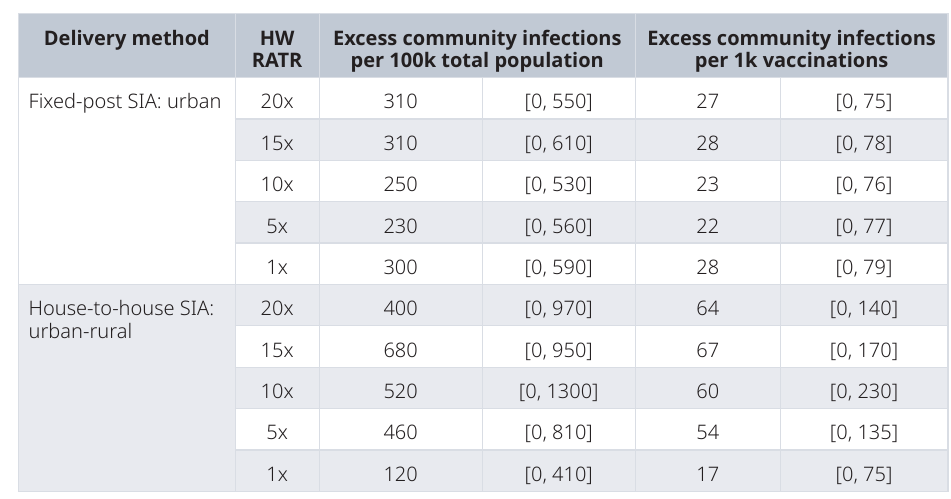
Table 3. Expected excess SARS-CoV-2 infections and infections-per-vaccination, under varying scenarios of relative acquisition and transmission risk (RATR) for health workers (HW) when SIA is undertaken at time of peak COVID-19 incidence. Bracketed ranges span mean outcomes for the six